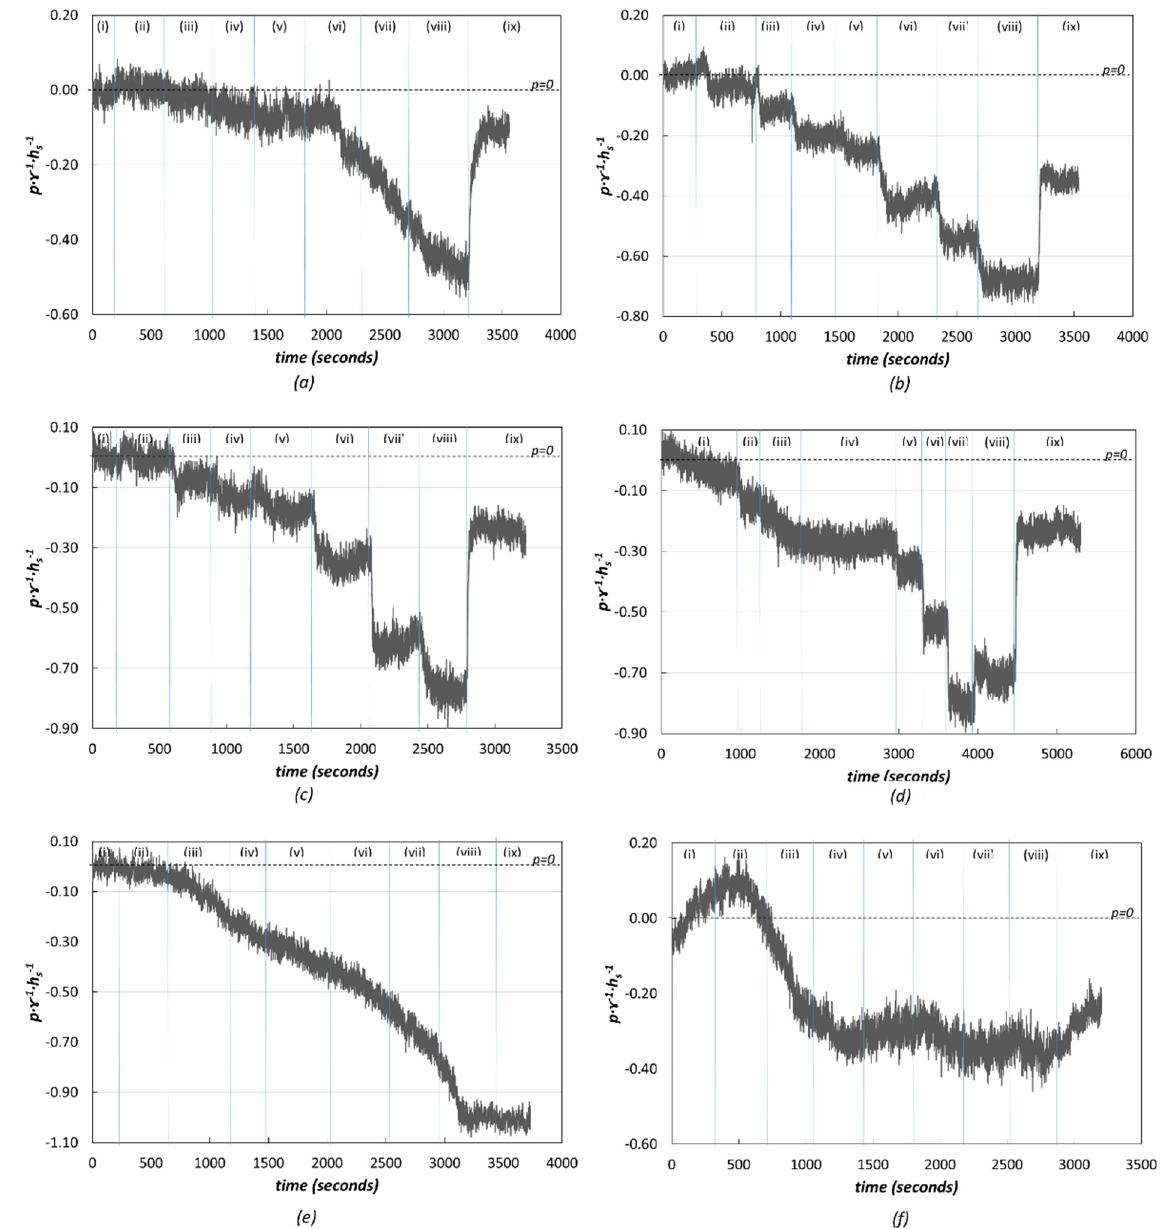
Figure 20. Hydrodynamic pressures on the base of the Amorwedge TM block ( w 1) in rows 5 ( a ), 10 ( b ), 15 ( c ), 25 ( d ), 30 ( e ) and 35 ( f ) for unit flow rates ( q ): (i) 0 m 2 s − 1 , (ii) 0.04 m 2 s − 1 , (iii) 0.08 m 2 s − 1 , (iv) 0.10 m 2 s − 1 , (v) 0.12 m 2 s − 1 , (vi) 0.16 m 2 s − 1